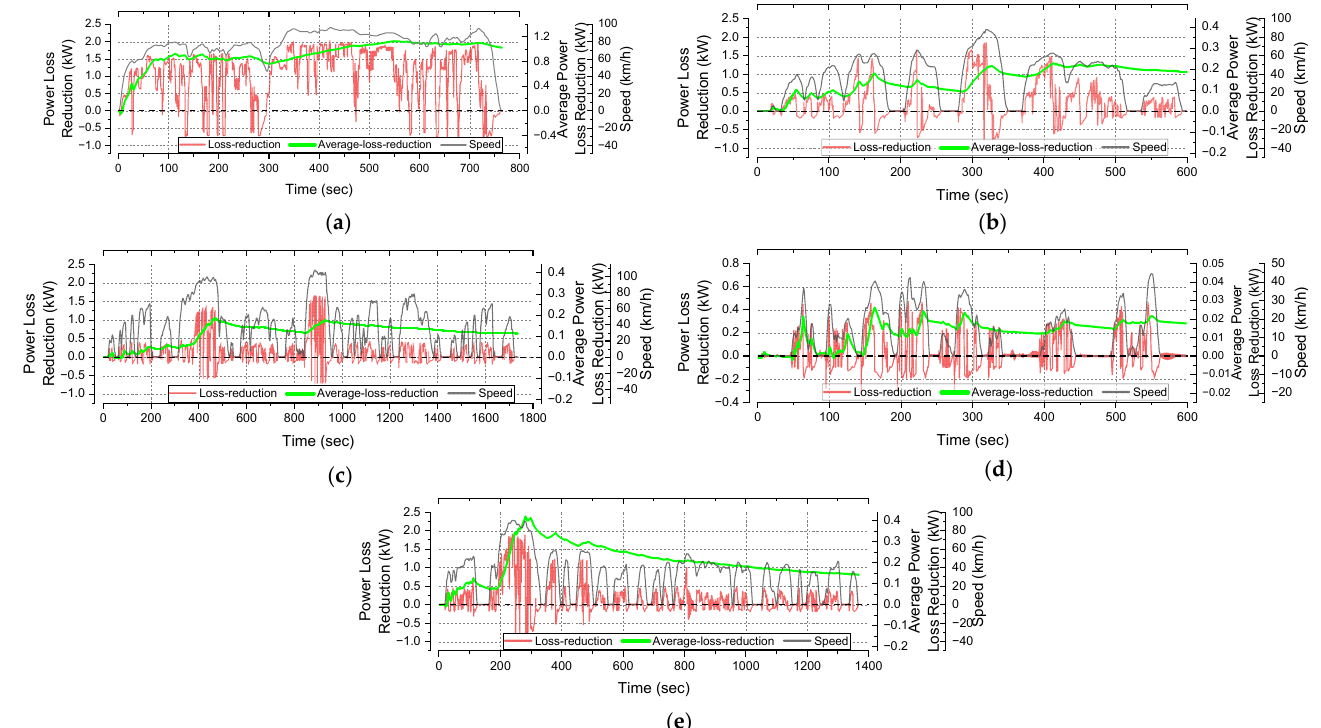
Figure 12. Loss-reduction and average-loss-reduction of drive motor power in five driving cycles using a reduction ratio of 10:1 for the front and rear wheels: ( a ) HWFET, ( b ) SC03, ( c ) LA92, ( d ) NYCC, ( e ) UDDS.